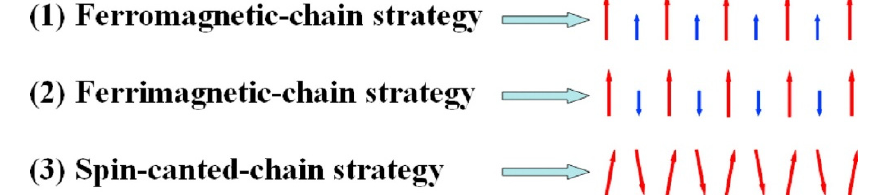
Figure 5. Possible strategies for single-chain magnets. Reprinted from [22], copyright 2010, with permission from Wiley.